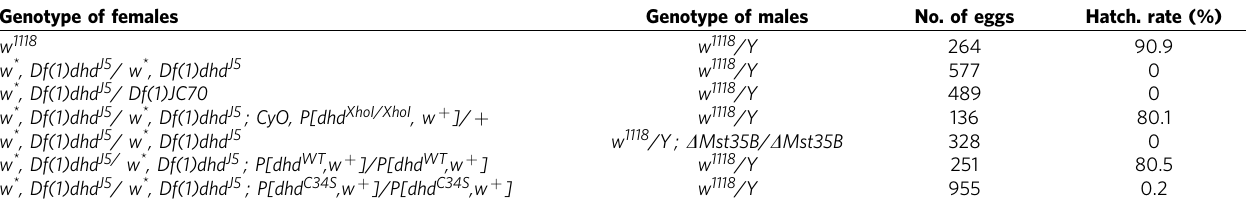
Table 1 | Embryo hatching rates. Genotype of females Genotype of